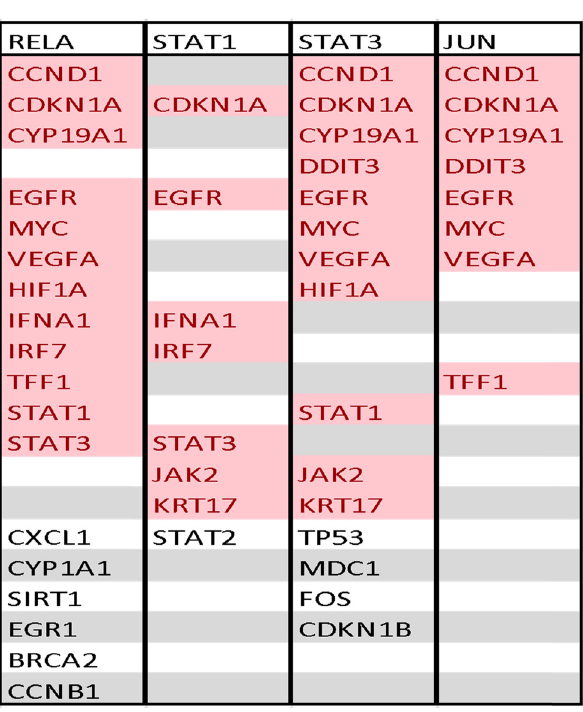
Table 1: BRCA1 target genes common between RELA, STAT1, STAT3, and JUN - regulated genes ( highlighted in pink